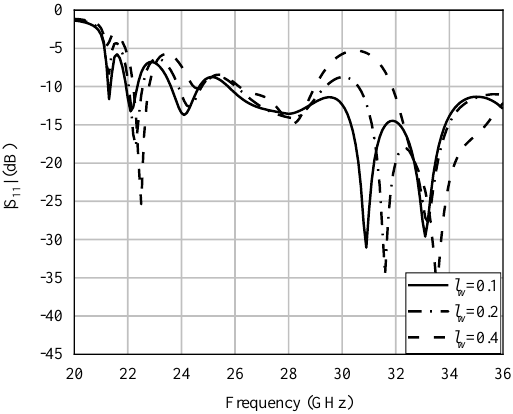
Figure 7. Simulated |S11| of the 1 × 5 interconnected ME dipole array versus l w .